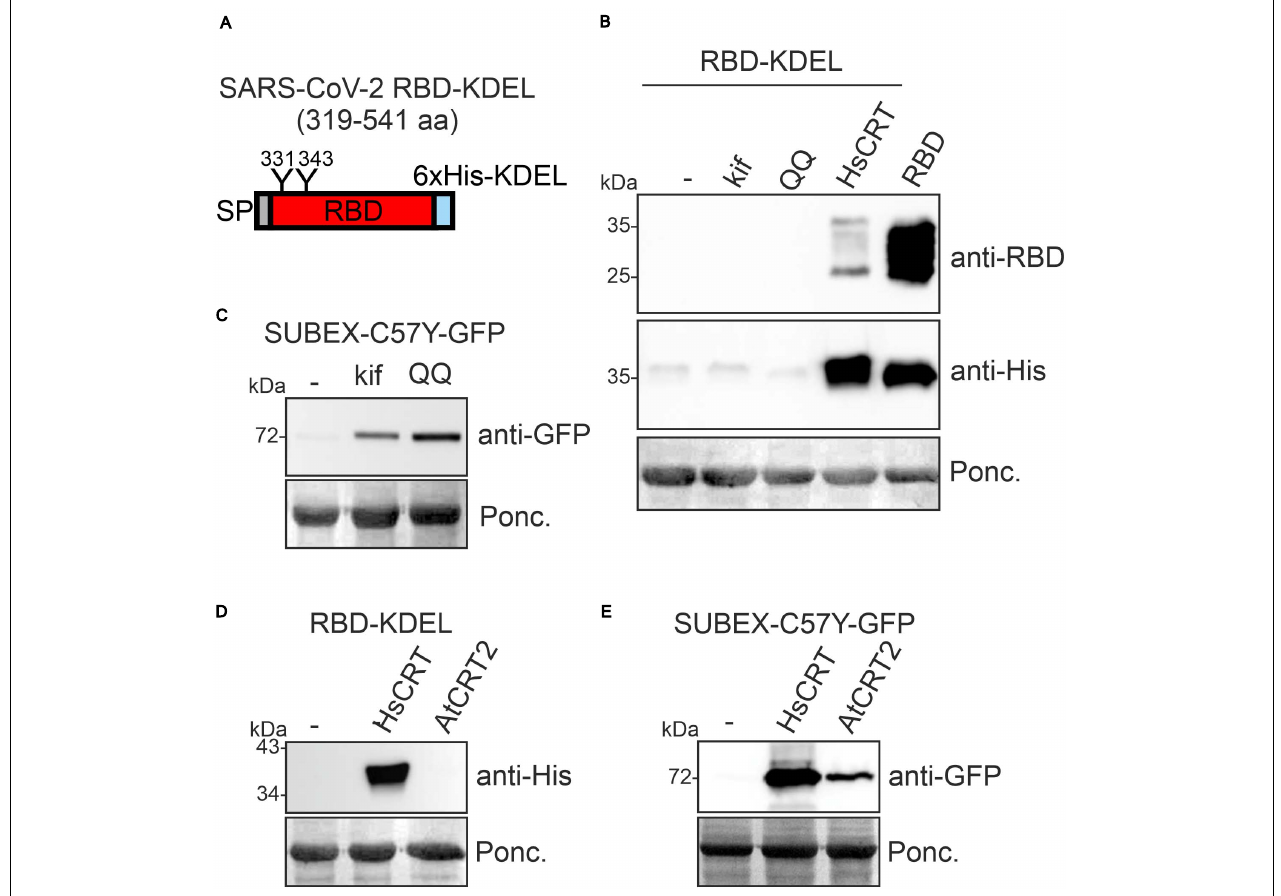
FIGURE 2 | Co-expression of human CRT results in RBD-KDEL accumulation in Nicotiana benthamiana . (A) Schematic illustration of the expressed SARS-CoV-2 RBD-KDEL variant. (B) RBD-KDEL was co-expressed with 50 µ M kifunensine (kif), Arabidopsis CDC48A-QQ (QQ) or human CRT (HsCRT). Samples were analyzed by immunoblotting 3 days after infiltration of N. benthamiana WT. Ponceau S staining (Ponc.) is shown as a loading control. RBD expression was included for comparison. (C) SUBEX-C57Y-GFP was co-expressed with kif or Arabidopsis CDC48A-QQ (QQ) and analyzed 3 days after infiltration of N. benthamiana WT. (D) RBD-KDEL was co-expressed with HsCRT or Arabidopsis CRT2 (AtCRT2). Both CRT variants were expressed with the pEAQ- HT vector and expression was analyzed 4 days after infiltration of N. benthamiana WT. (E) SUBEX-C57Y-GFP was co-expressed with HsCRT or AtCRT2 and analyzed 3 days after infiltration of N. benthamiana